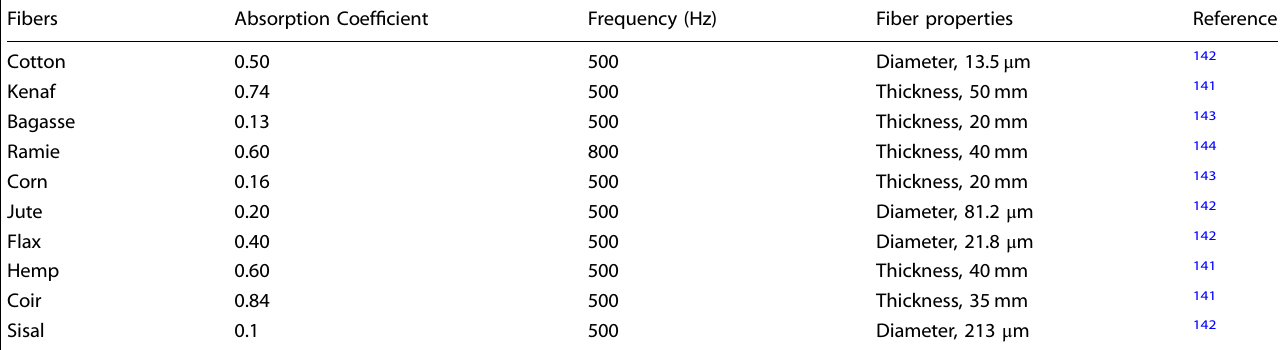
Table 5. Some natural fi bers acoustical absorption coef fi